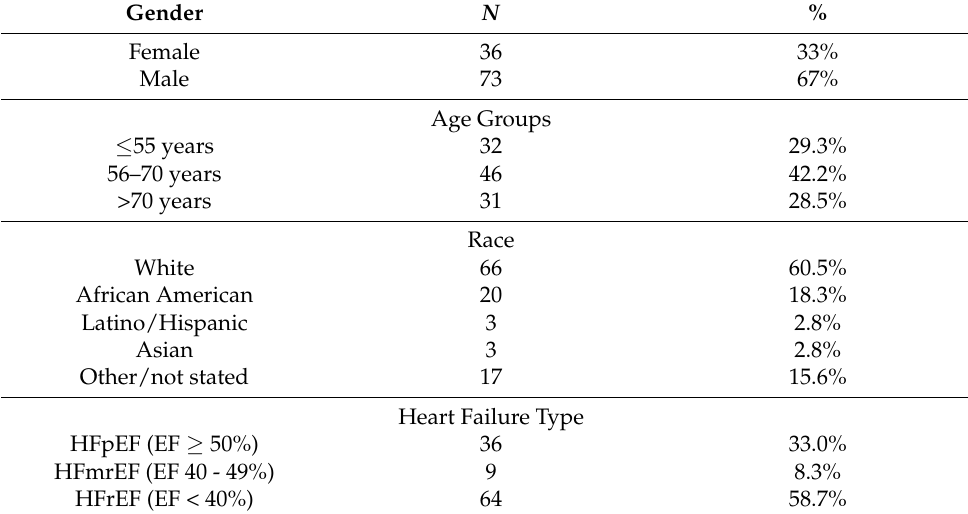
Table 1. Demographics of the surveyed population.